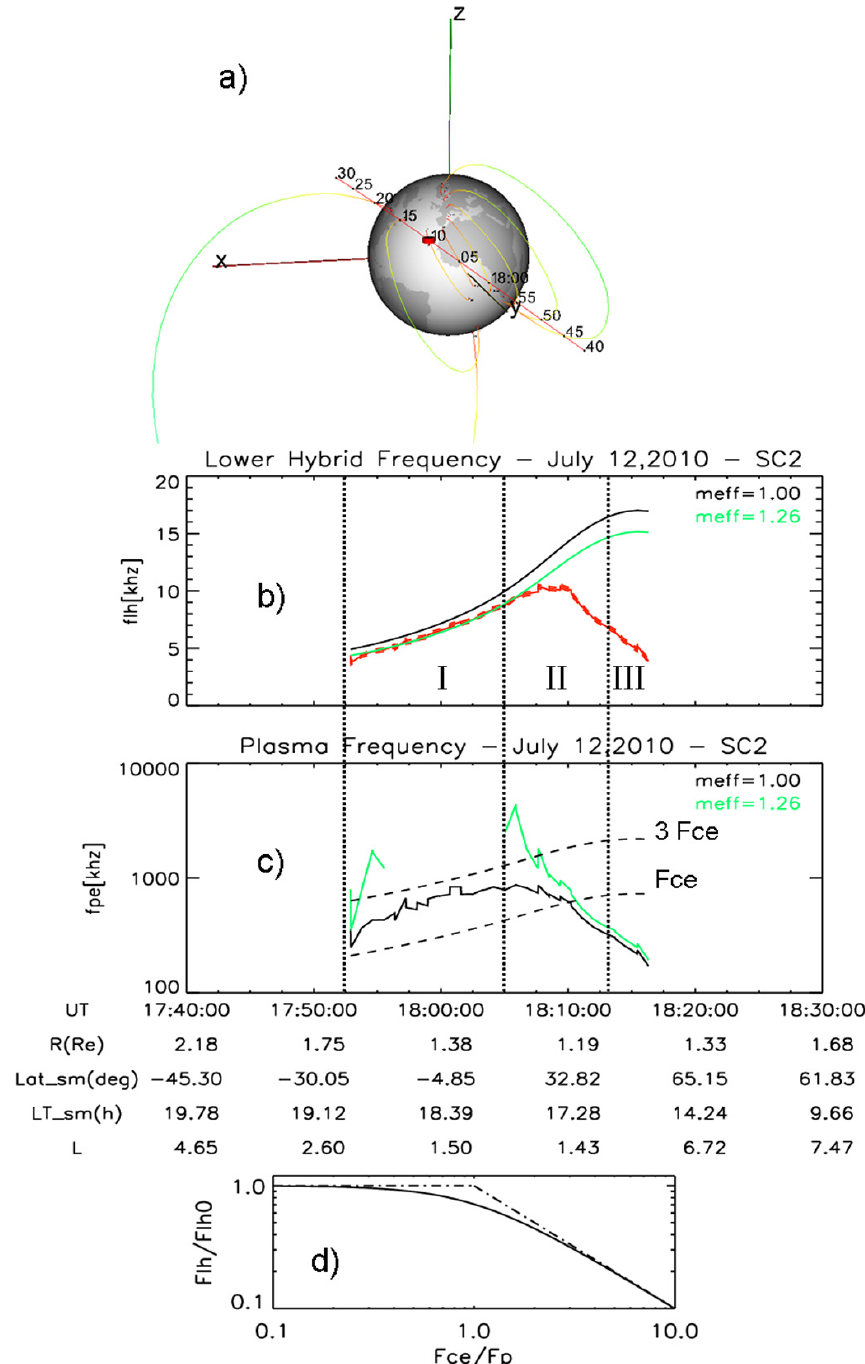
Fig. 5. Variation of magnetic field intensity and plasma frequency on C2, event of 12 July 2010. (a) Magnetic field lines crossed by C2 from 17:45 to 18:20UT, where the magnetic field intensity is colour coded (decreasing values from red to green). View produced by OVT tool. (b) F lh variations in the limiting case of infinite F p ( F lh proportionnal to F ce ) under two assumptions about effective mass, either M eff = 1 as given by the black (upper-most) curve or M eff = 1 . 26 as given by the green curve. Measured F lh values are plotted in red. Different relative variations are pointed out by splitting time into intervals I, II, and III; (c) derived plasma frequency for the two ion compositions tested. (d) theoretical variations (with M eff = 1) showing which of F p or F ce parameter governs the value F lh